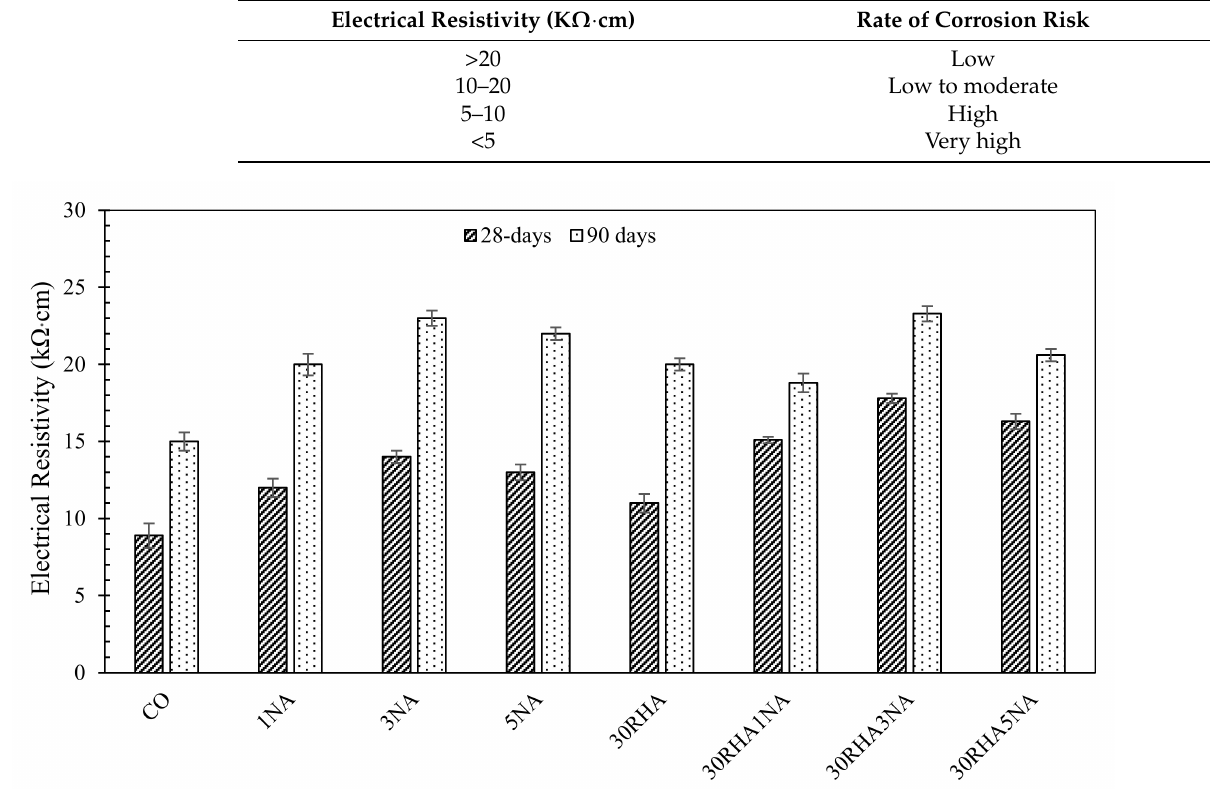
Figure 4. Electrical resistivity (k Ω · cm) of SC mortars at different